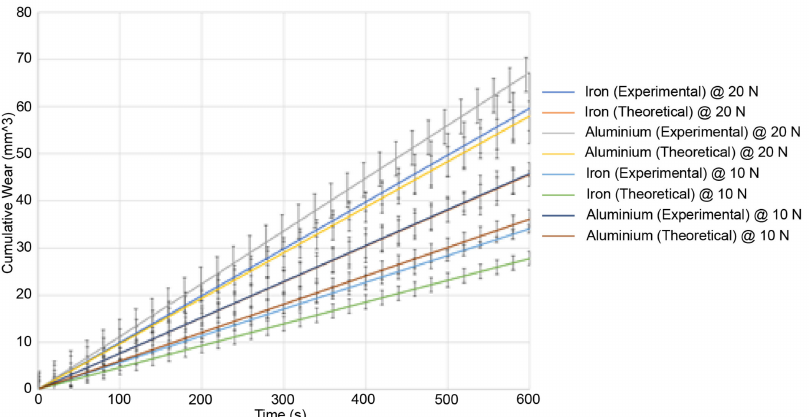
Figure 9. Experimental results for the wear at a 20 N load and 60 ◦ C for aluminium (grey) and iron (blue). Theoretical results at a 20 N load and 60 ◦ C for aluminium (yellow) and iron (orange). Experimental results at a 10 N load and 60 ◦ C for aluminium (violet) and iron (teal). Theoretical results at a 10 N load and 60 ◦ C for aluminium (brown) and iron (green).